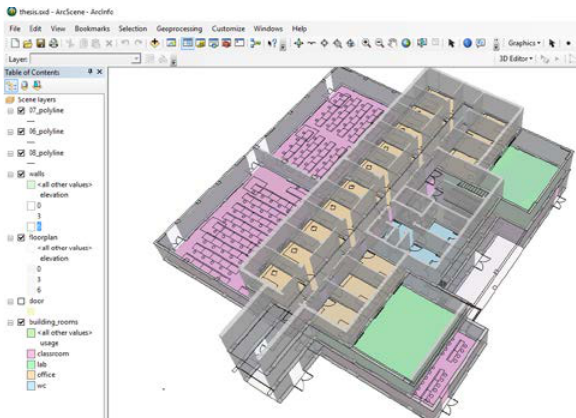
Figure 3. Building’s interior in 3D. Different colors apply to different uses